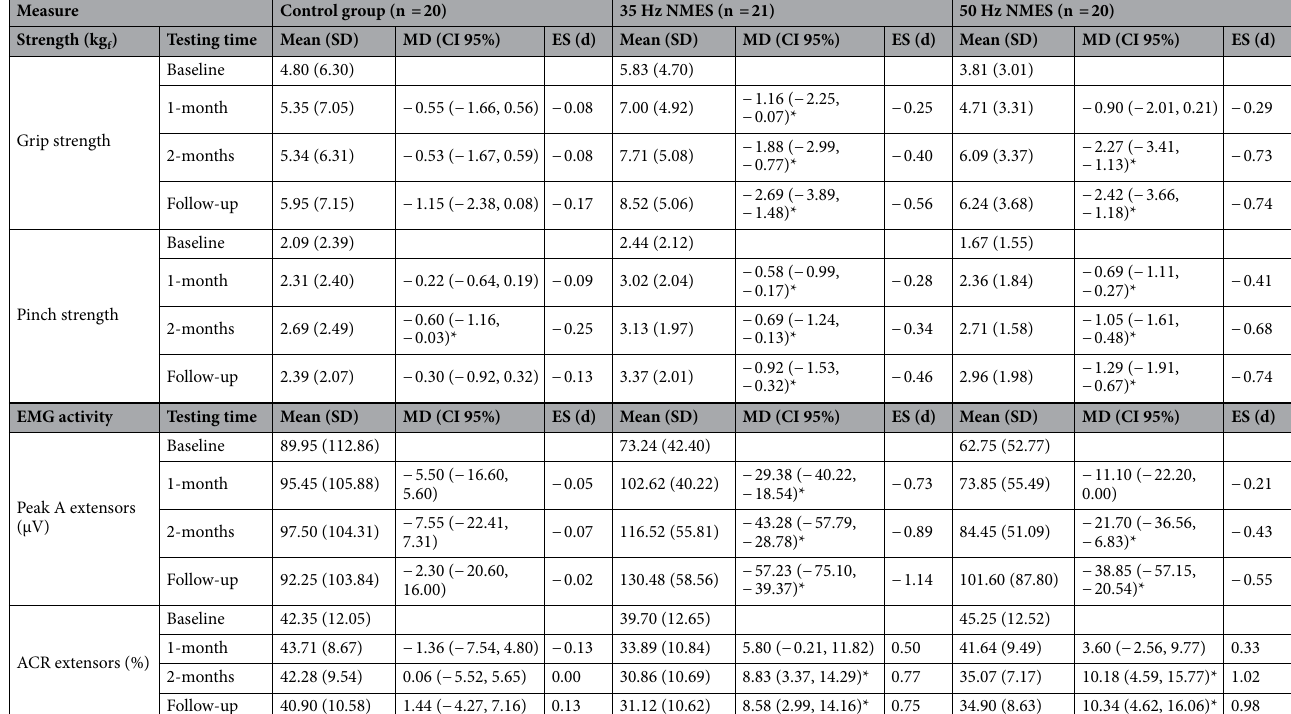
Table 3. Means, standard deviations, mean differences, confidence intervals and effect sizes of the variables related to the hand strength and the EMG activity in all the time points. SD Standard deviation, MD Mean